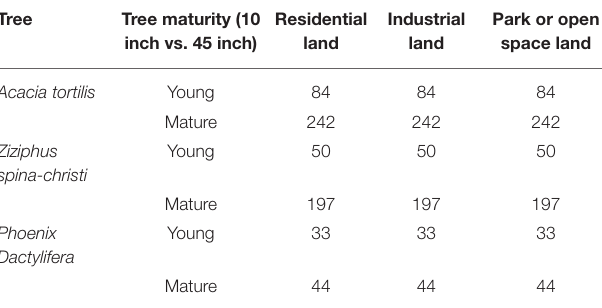
TABLE 4 | Annual energy saving kWh of cooling and reduced consumption of oil and natural gas by young vs. mature urban trees when planted in different